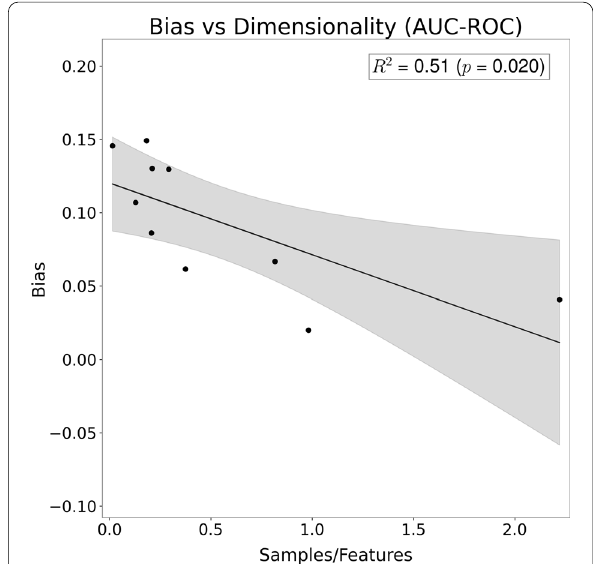
Fig. 3 Scatter plot relating the number of samples per feature against the observed bias in AUC-ROC, when feature selection is applied incorrectly, for each